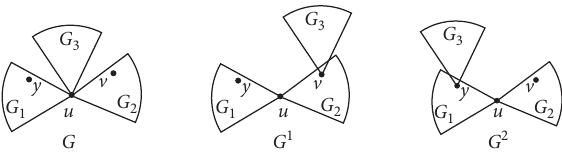
Figure 2: A graph transformation from G to G 1 and G 2